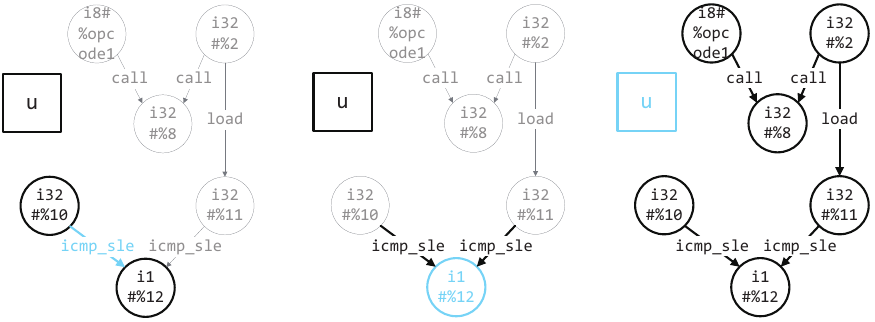
Figure 4. The update process of the DFSGraph